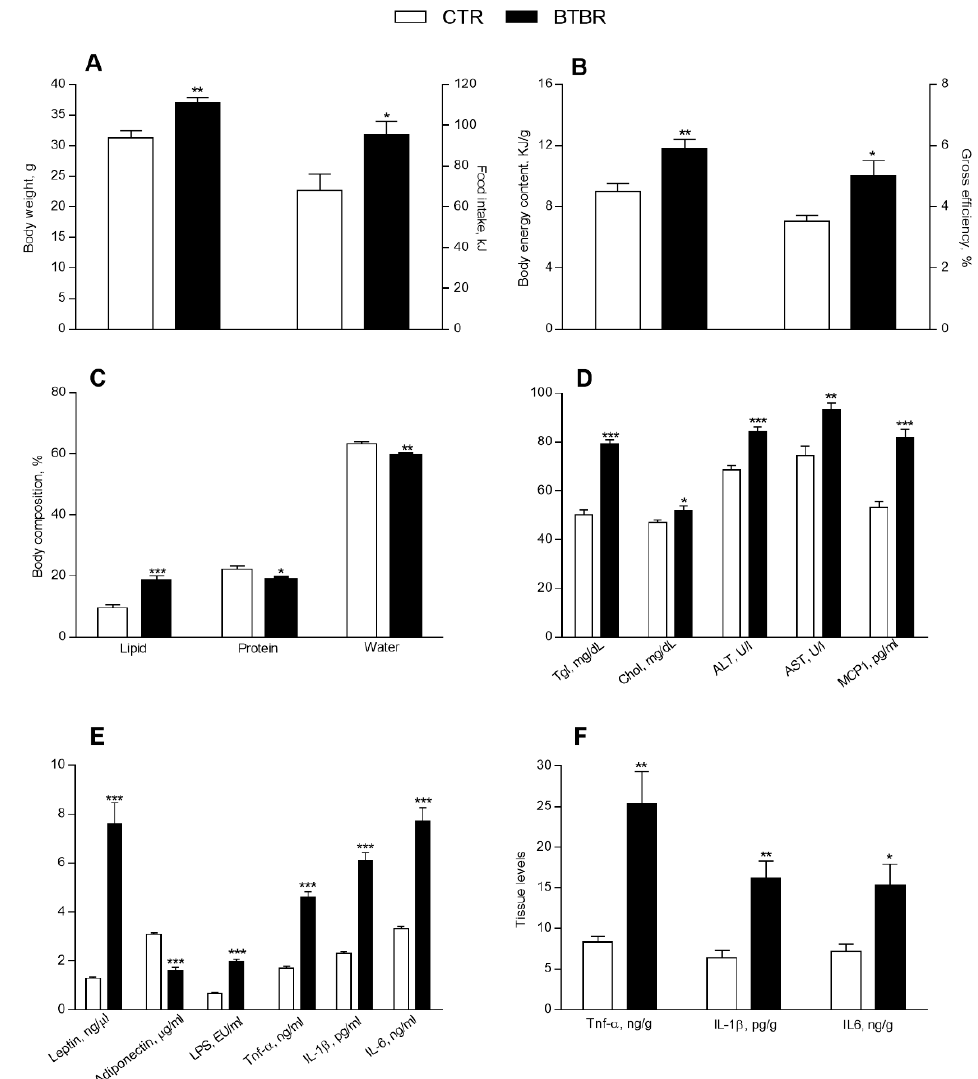
Figure 1. Metabolic and inflammatory profile in control and BTBR mice. Body weight and daily food intake at the end of treatment ( A ). Body energy content and gross efficiency ( B ), body lipid, protein, and water percentages ( C ). Serum levels of triglycerides, cholesterol, alanine aminotransferase (ALT), aspartate aminotransferase (AST), monocyte chemoattractant protein-1 (MCP-1) ( D ), leptin, adiponectin, lipopolysaccharide (LPS), tumor necrosis factor (TNF- α ), interleukin-1 β (IL-1 β ), interleukin-6 (IL-6) ( E ). Hepatic levels of TNF- α , IL-1 β , IL-6 ( F ). Data are presented as means ± SEM from n = 7 animals/group. * p < 0.05, ** p < 0.01, *** p < 0.001 BTBR vs. control (CTR).